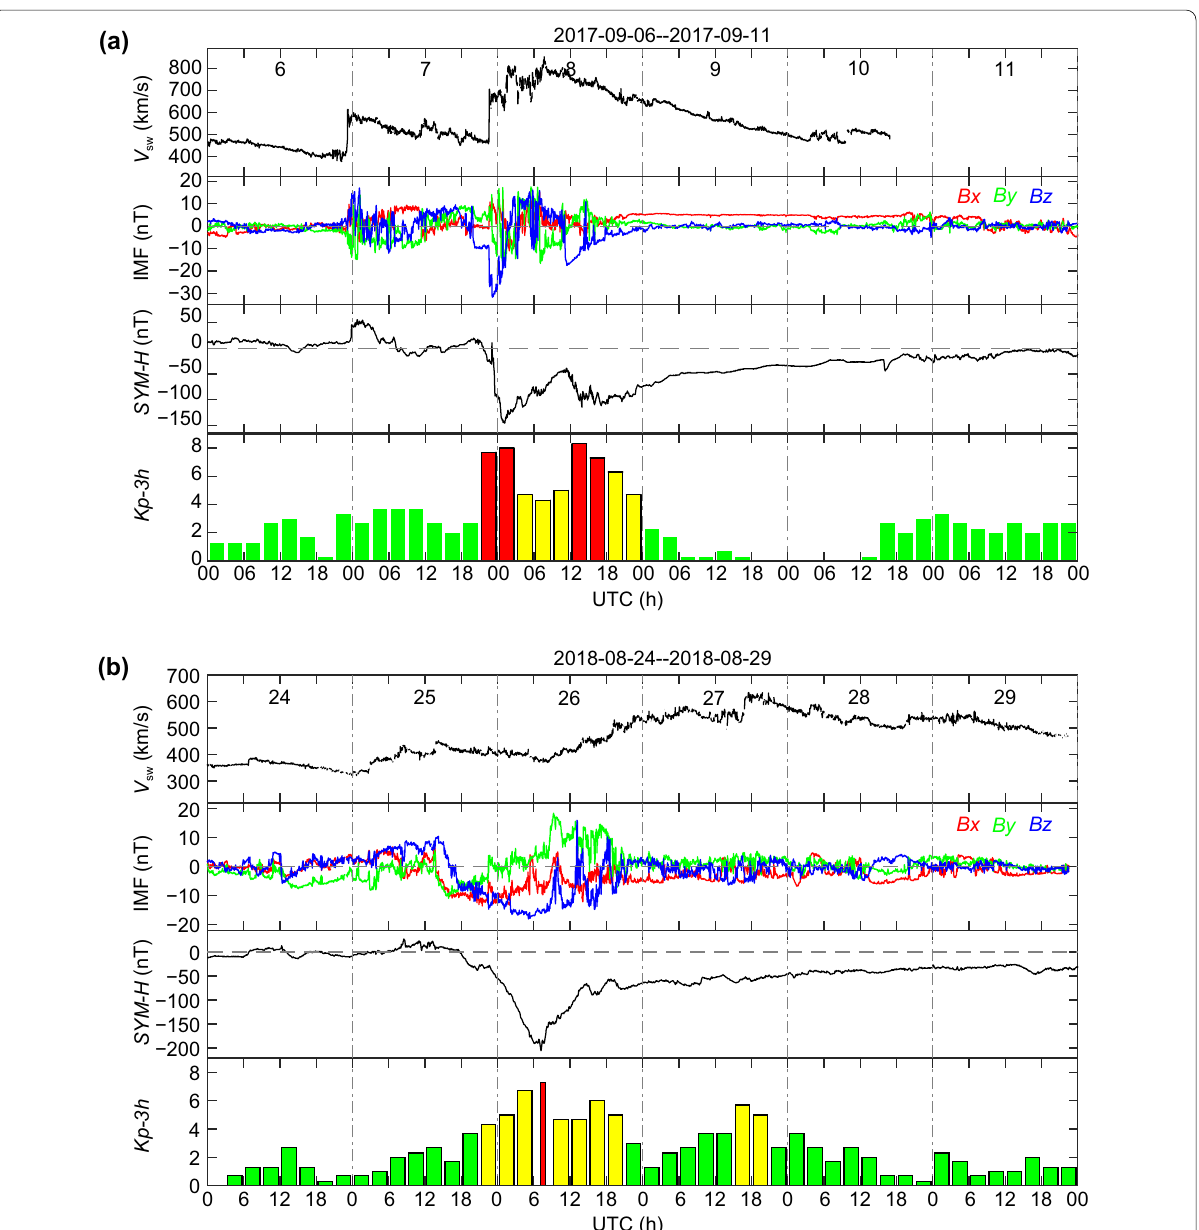
Fig. 1 The variations of solar wind velocity, IMF components, SYM-H index, and 3-h Kp index during the geomagnetic storm on a 6–11 September 2017 and b 24–29 August